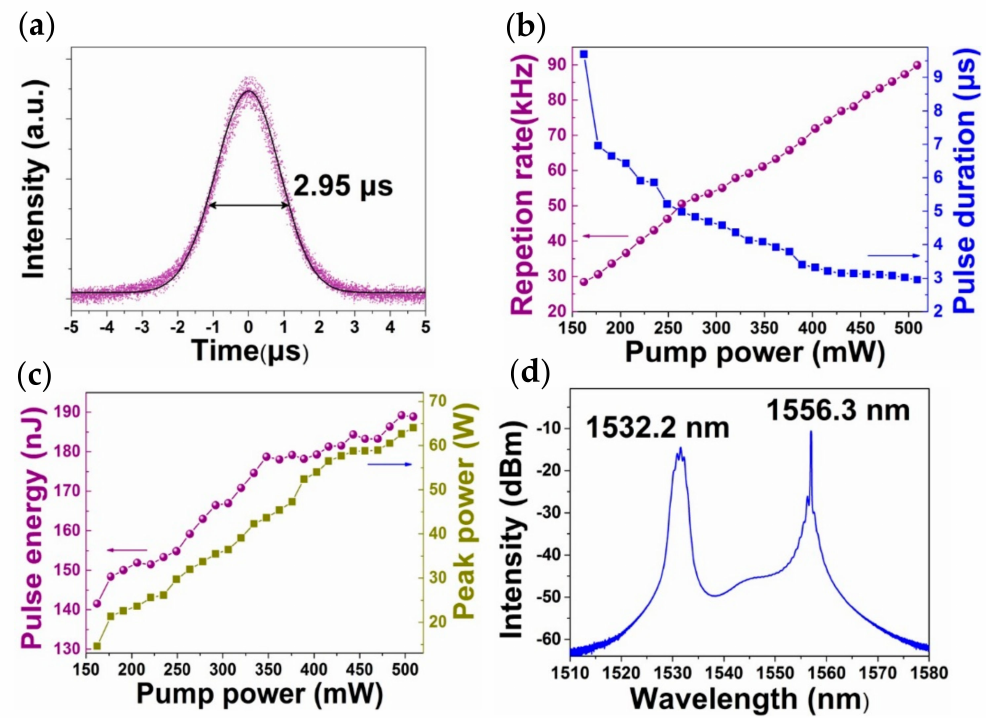
Figure 8. Laser performance: ( a ) Minimum pulse profile with a Gaussian-fitting standard deviation of 7.36 × 10 − 4 . ( b ) Pulse width and repetition rate versus pump power. ( c ) Pulse energy and peak power versus pump power. ( d ) Output spectrum with a pump power of 500 mW.